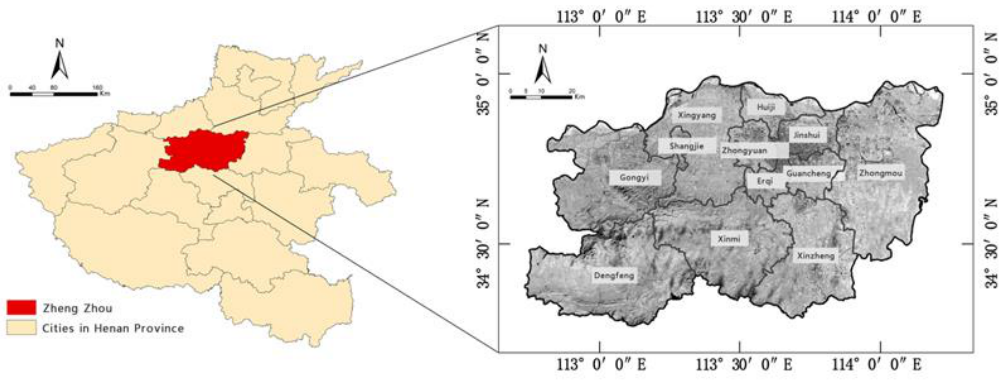
Figure 1. Map of the study